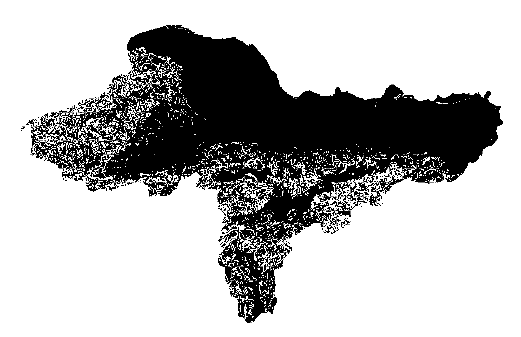
Figure 3 . Varaždinska county slope model